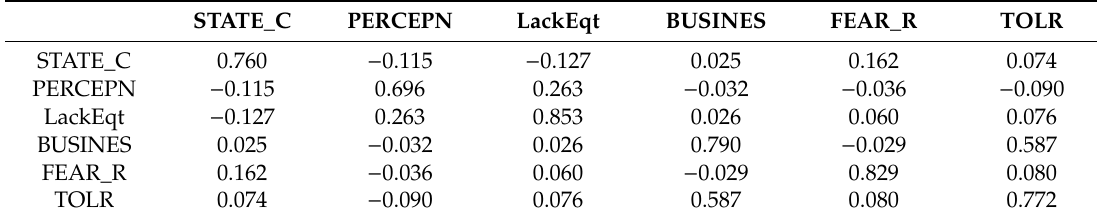
Table 4. Discriminant validity: Correlations among latent variables with sq. rts. of